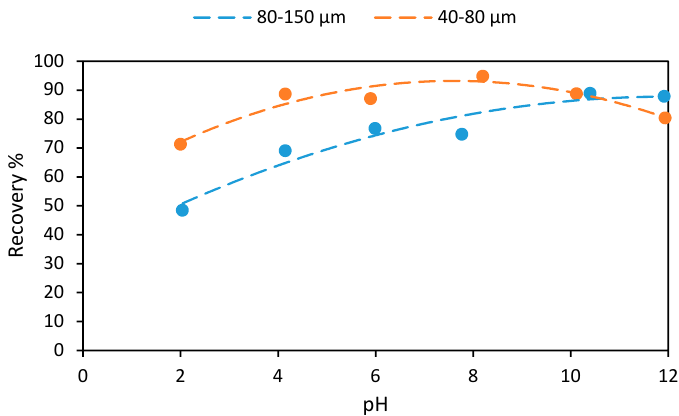
Figure 5. The effect of calcium activation on the coarse and fine fractions (NaOl: 250 mg/L, CaCl 2 : 120 mg/L).